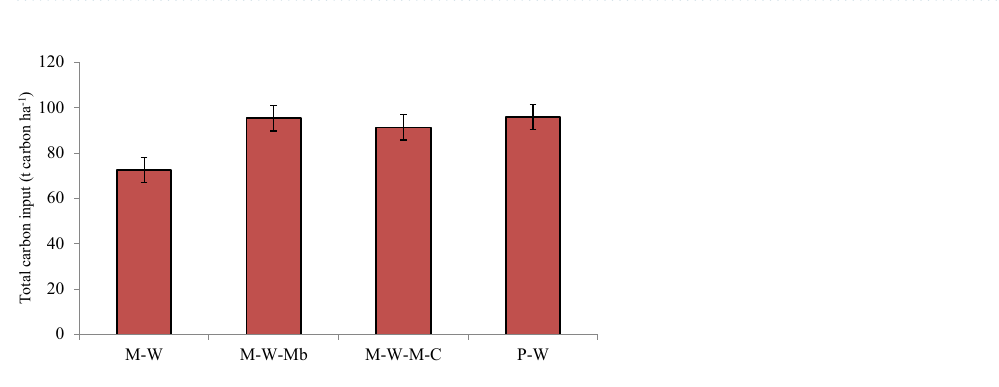
Figure 3. Impact of cropping sequence on yields over time; lowercase letters (a–c) delineates significant difference at p ≤ 0.05 using Tukey’s honest significance test.